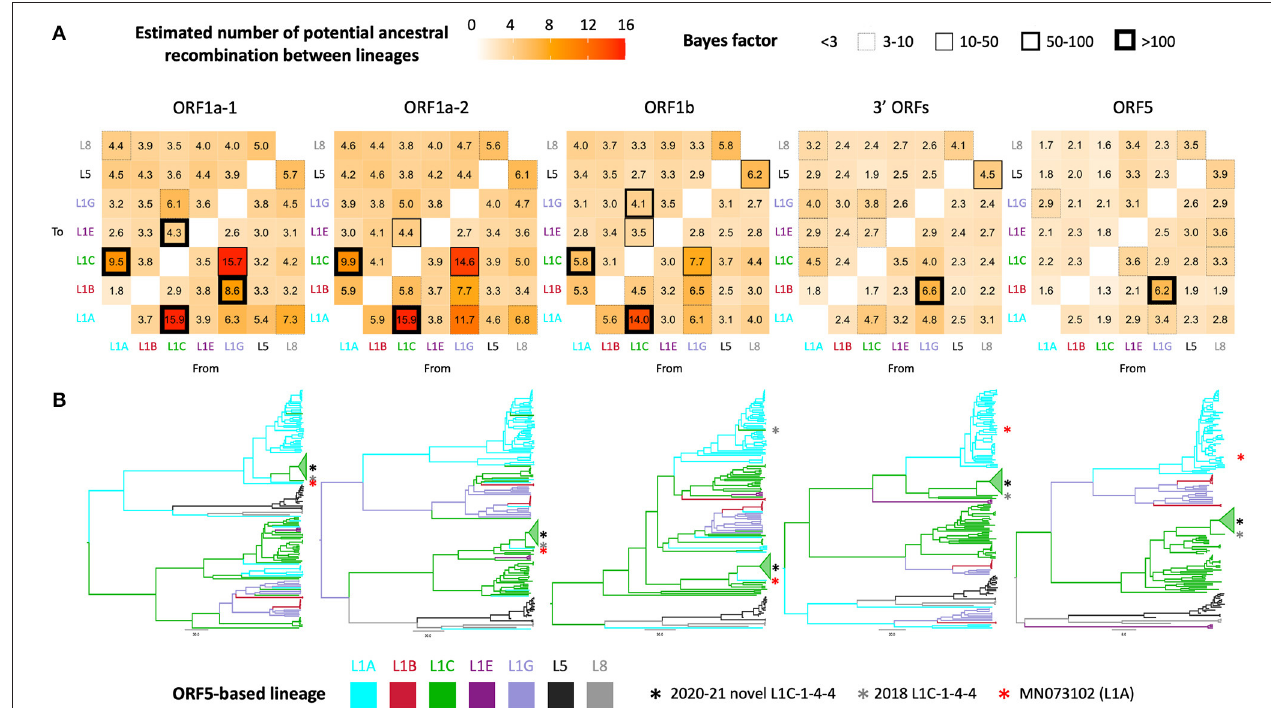
FIGURE 2 | Discrete trait analysis of PRRSV-2 lineage/sub-lineage recombination. (A) Heat map showing number of potential ancestral recombination between lineages/sub-lineages of each genomic fragment estimated from the trait transitions. Cell border thickness represents Bayes factor (BF) support for each recombination. (B) Bayesian MCC trees colored by ancestral ORF5-based lineage or sub-lineage. Asterisks locate the phylogenetic position of taxa of interest.